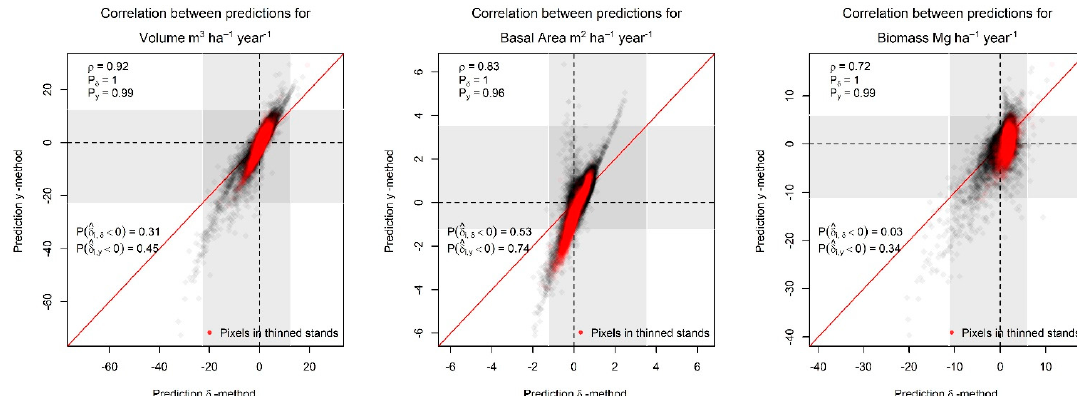
Figure B2. Comparison pixel-level predictions for V, BA and B using the δ -modeling method and y -modeling method predictions for the unsampled stands subject to thinnings are in red. The range of V, BA and B observed in the sample is indicated by the grey ribbons. The proportions, P δ and P y , of predictions within the range of values observed in the sample, and the correlation between predictions from both methods are indicated in the upper left corner. The proportion of pixels in the thinned stands where the δ -modeling method and y -modeling method predict losses (i.e., P ( ˆ δ i , δ < 0 ) and P ( ˆ δ i , y < 0 ) ) are indicated on the lower left quadrant of the figure.